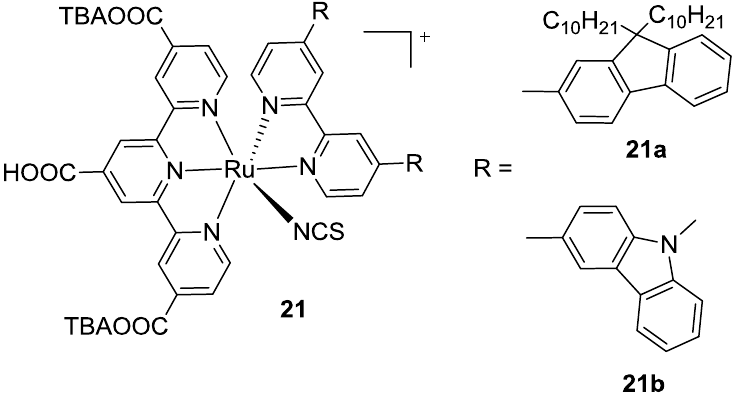
Figure 16. Bipyridine ancillary ligands with fluoren-2-yl or carbazol-3-yl substitutions [100].